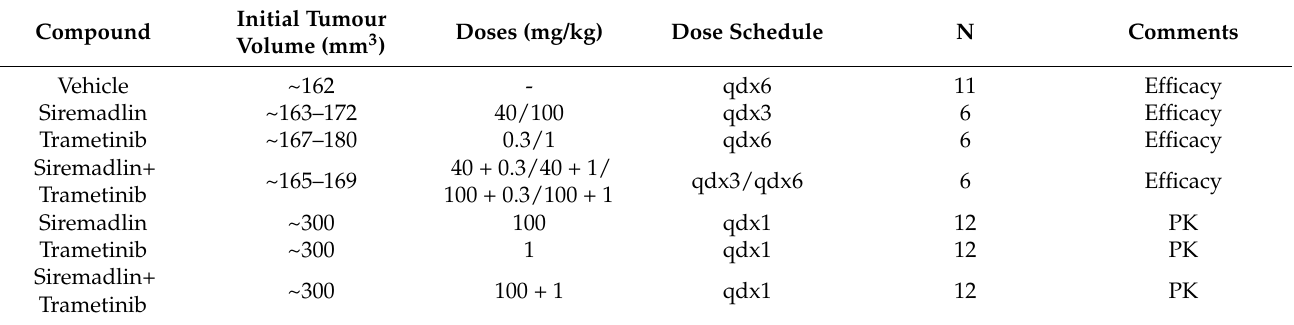
Table 8. Summary of performed in vivo studies on CD-1 nude mice xenografted with A375